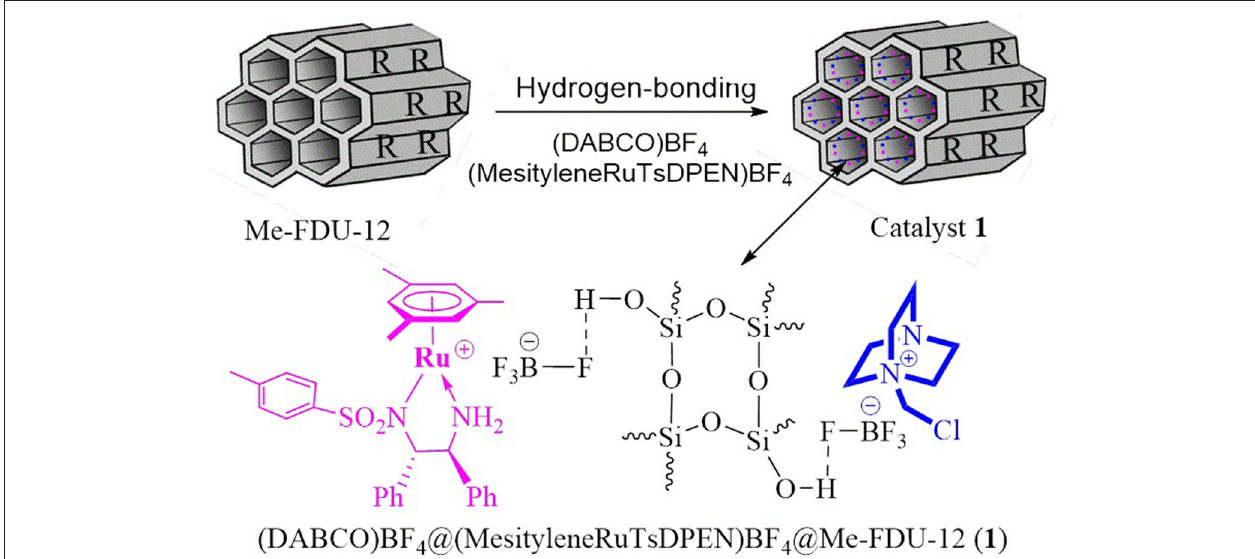
FIGURE 1 | Preparation of heterogeneous catalyst